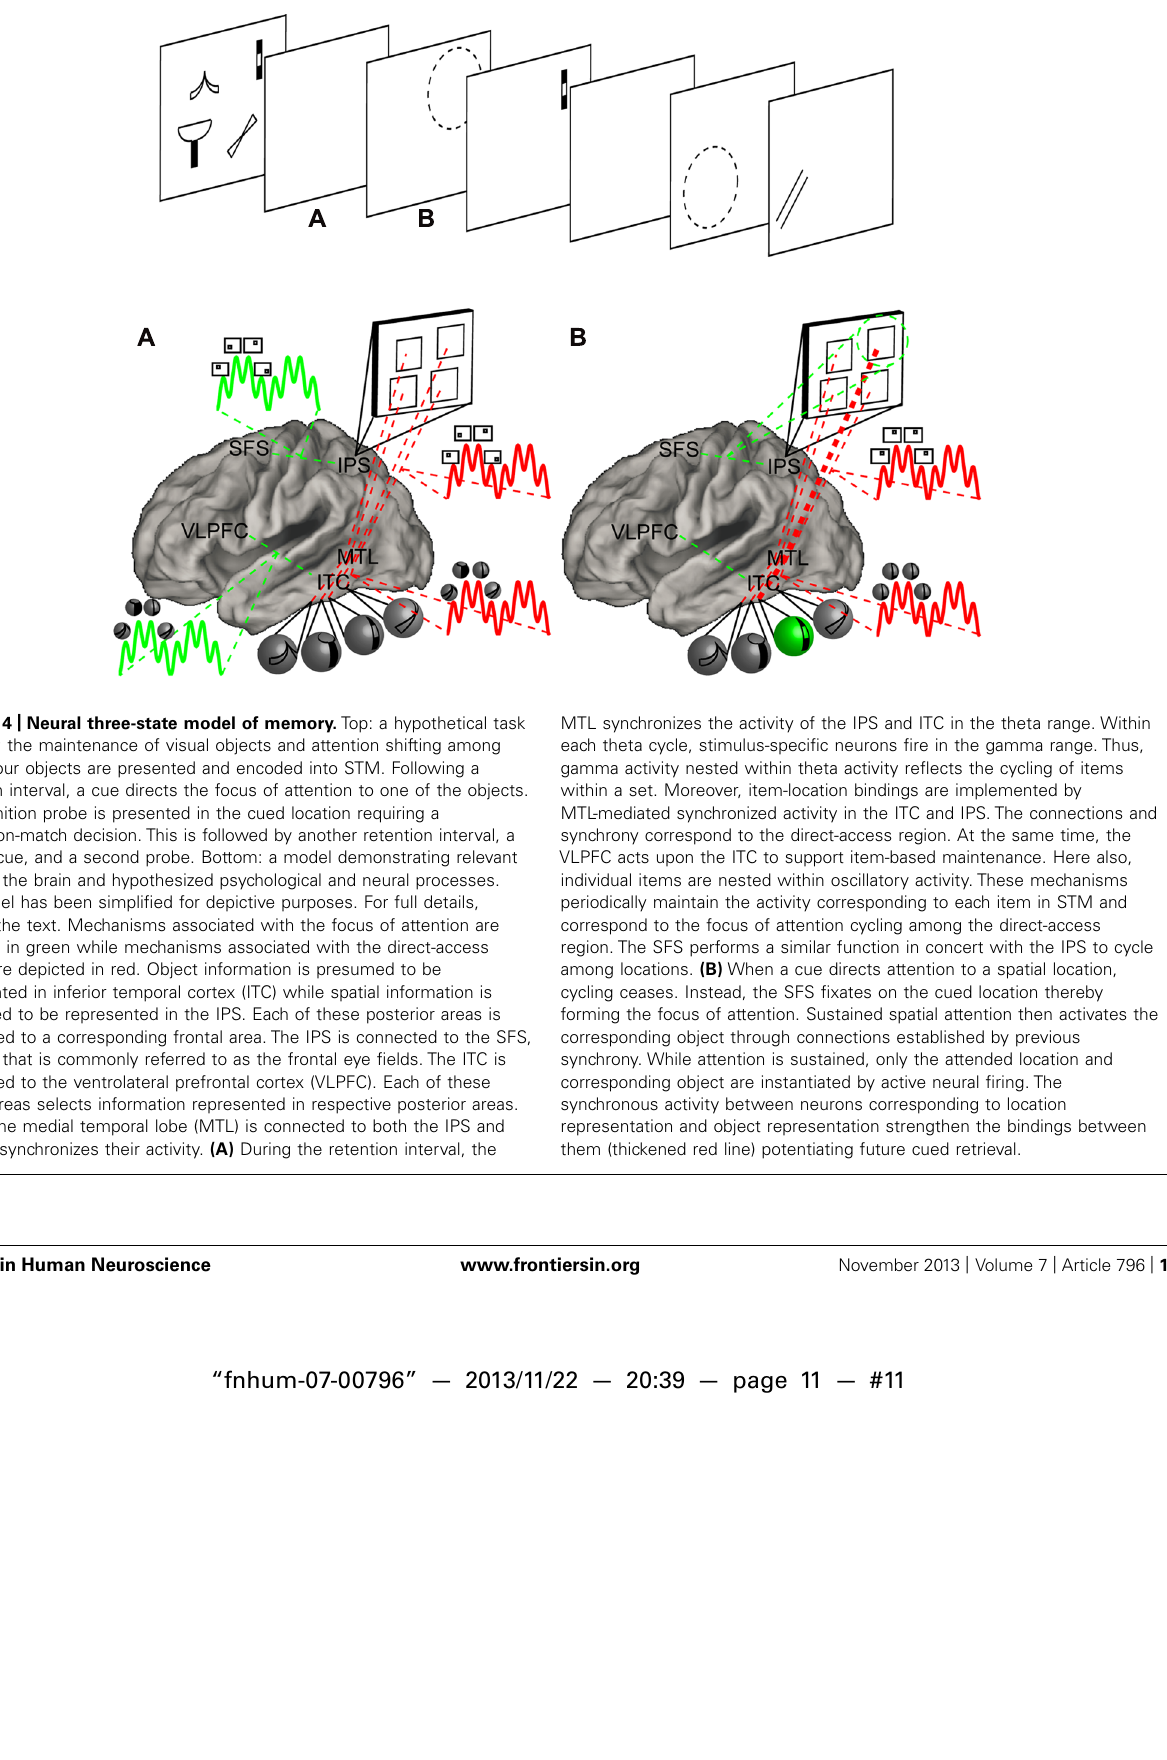
FIGURE 4 | Neural three-state model of memory. Top: a hypothetical task requiring the maintenance of visual objects and attention shifting among them. Four objects are presented and encoded into STM. Following a retention interval, a cue directs the focus of attention to one of the objects. A recognition probe is presented in the cued location requiring a match/non-match decision. This is followed by another retention interval, a second cue, and a second probe. Bottom: a model demonstrating relevant areas of the brain and hypothesized psychological and neural processes. The model has been simplified for depictive purposes. For full details, consult the text. Mechanisms associated with the focus of attention are depicted in green while mechanisms associated with the direct-access region are depicted in red. Object information is presumed to be represented in inferior temporal cortex (ITC) while spatial information is presumed to be represented in the IPS. Each of these posterior areas is connected to a corresponding frontal area. The IPS is connected to the SFS, a region that is commonly referred to as the frontal eye fields. The ITC is connected to the ventrolateral prefrontal cortex (VLPFC). Each of these frontal areas selects information represented in respective posterior areas. Finally, the medial temporal lobe (MTL) is connected to both the IPS and ITC and synchronizes their activity. (A) During the retention interval, the